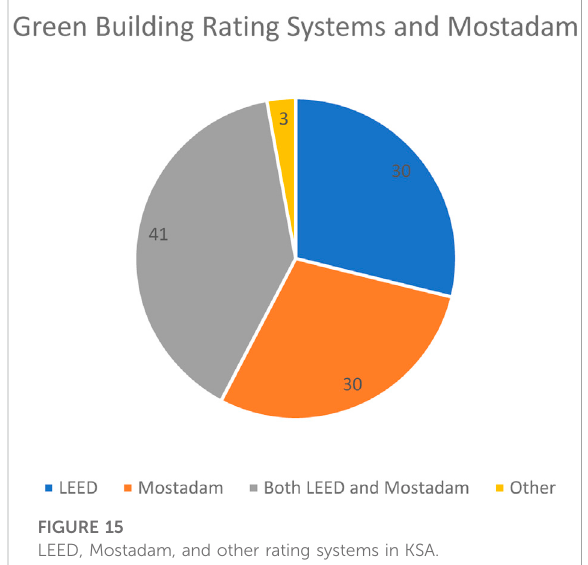
FIGURE 15 LEED, Mostadam, and other rating systems in